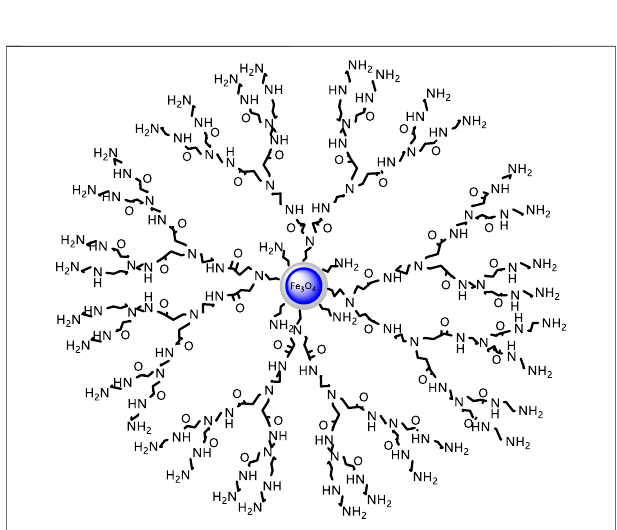
FIGURE 3 | Synthesis of the third-generation branched molecule 3-